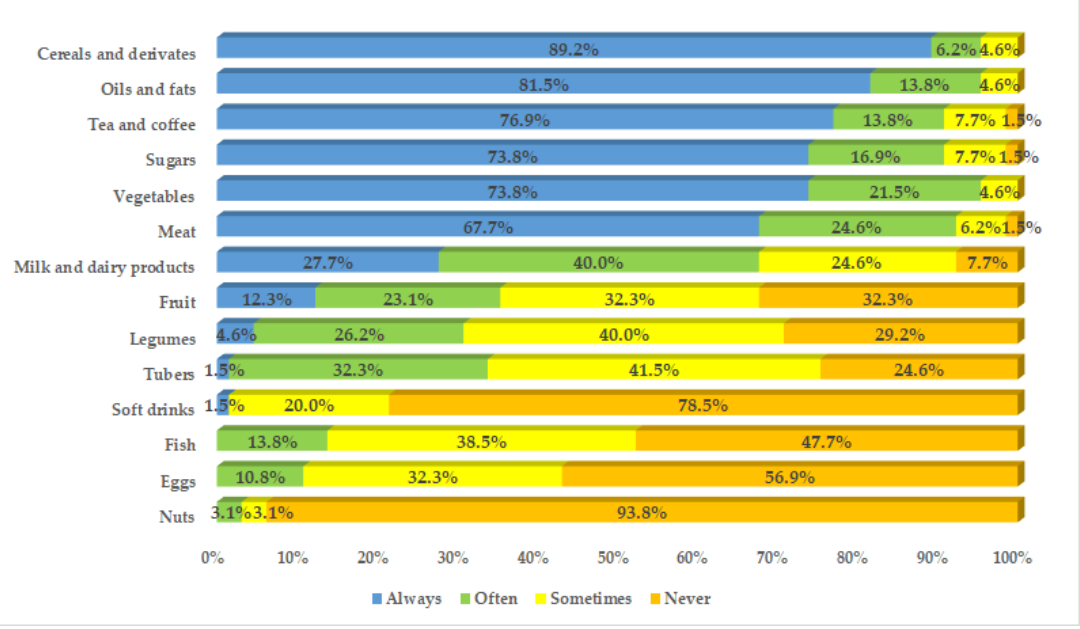
Figure 1. Propensity of the Saharawi diabetic women to the consumption of the different food groups.